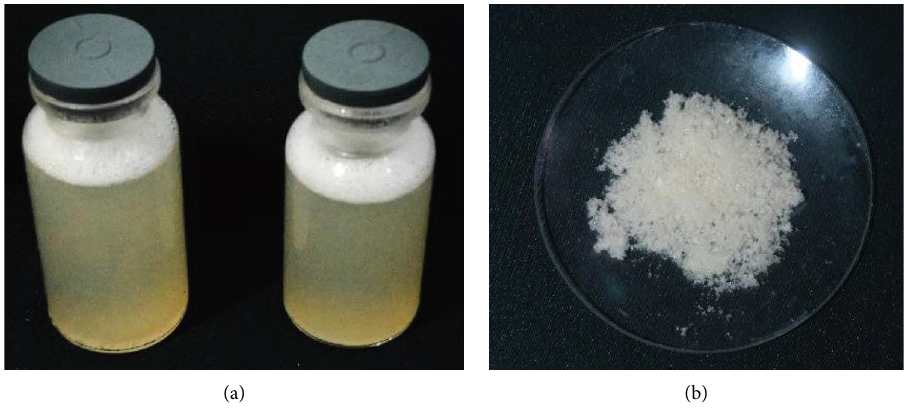
Figure 1: Te appearance of hydrogels (a) before drying and (b) after the drying process. Table 2: Particle sizes, polydispersity indexes, and zeta potentials of hydrogels with diferent initial cell concentrations. Initial cell number (log CFU/mL)